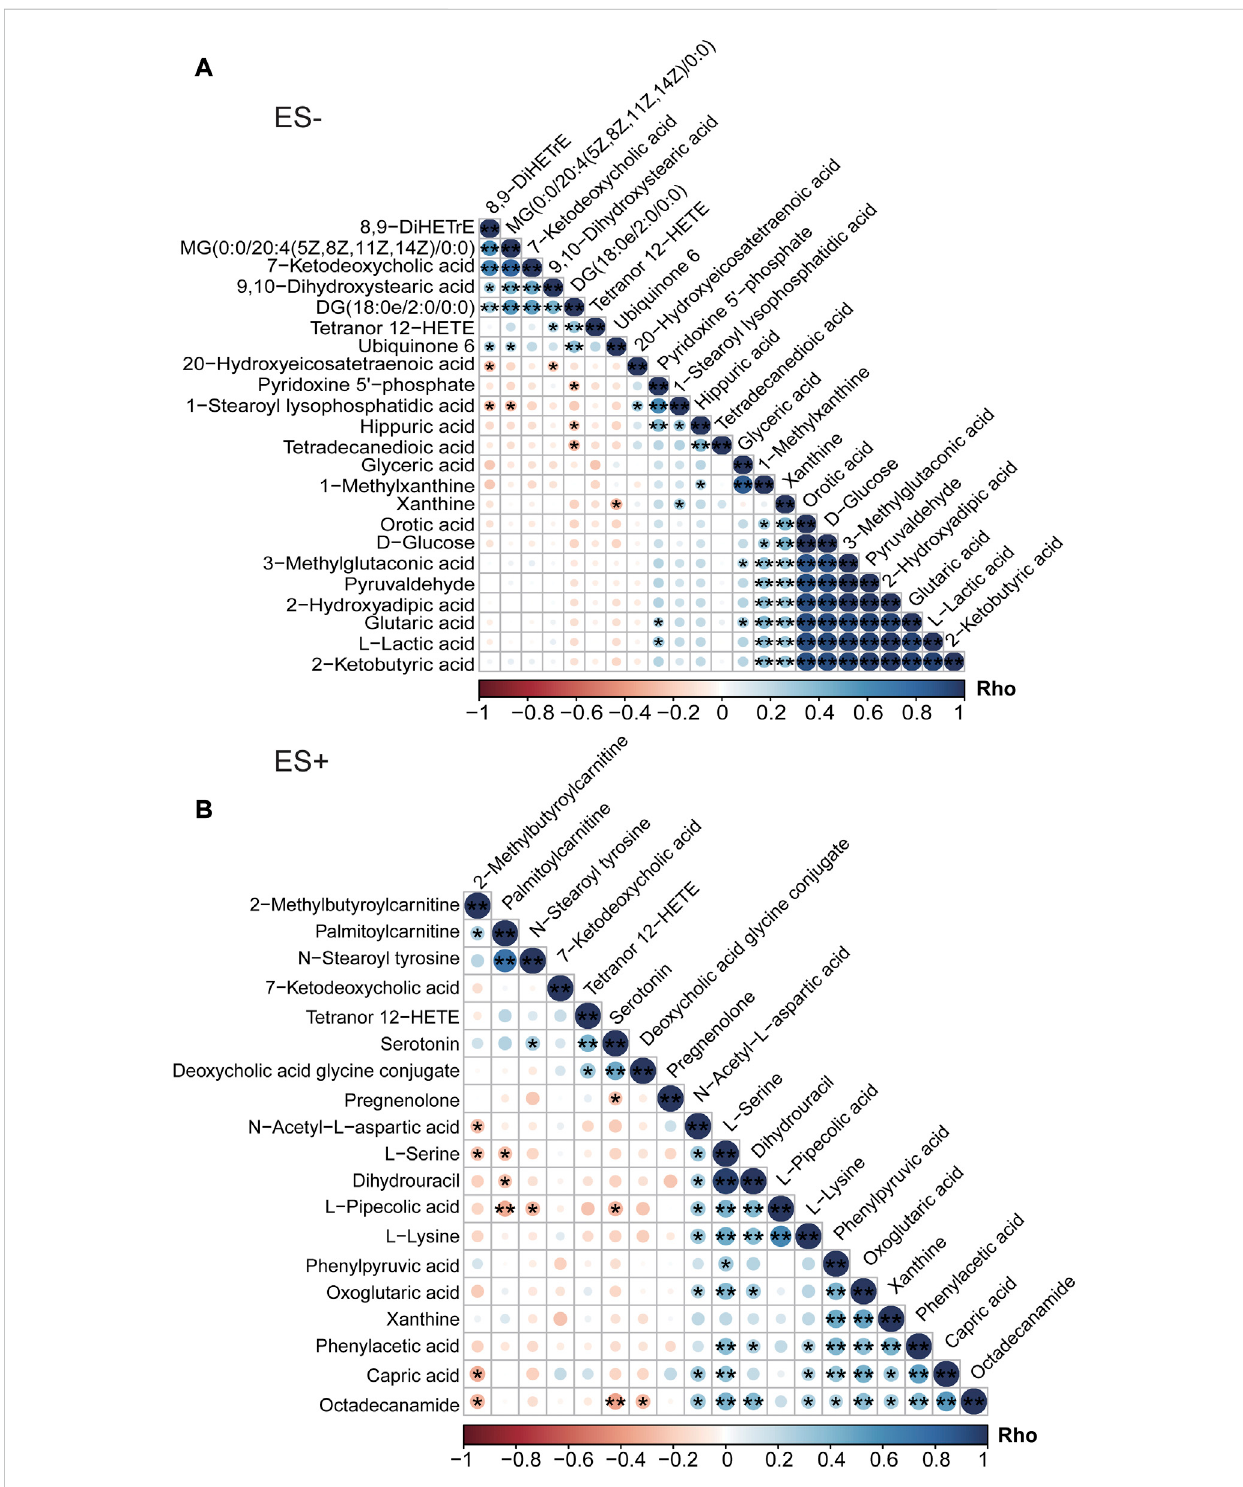
FIGURE 3 Association analysis of differential metabolites between HTN-S patients and HTN-NS controls by Spearman correlation. (A) , Co-abundance correlation of the distinct metabolites identi fi ed in HTN-S as compared with HTN-NS based on ES- mode. (B) , Heat map depicting the potential relationshipbetweendifferentmetaboliccompositionsinES+.Negativecorrelationisdescribedinorangeandpositivecorrelationislabeledinblue.*, p < 0.05; **, p < 0.01; ***, p < 0.001; Spearman ’ s